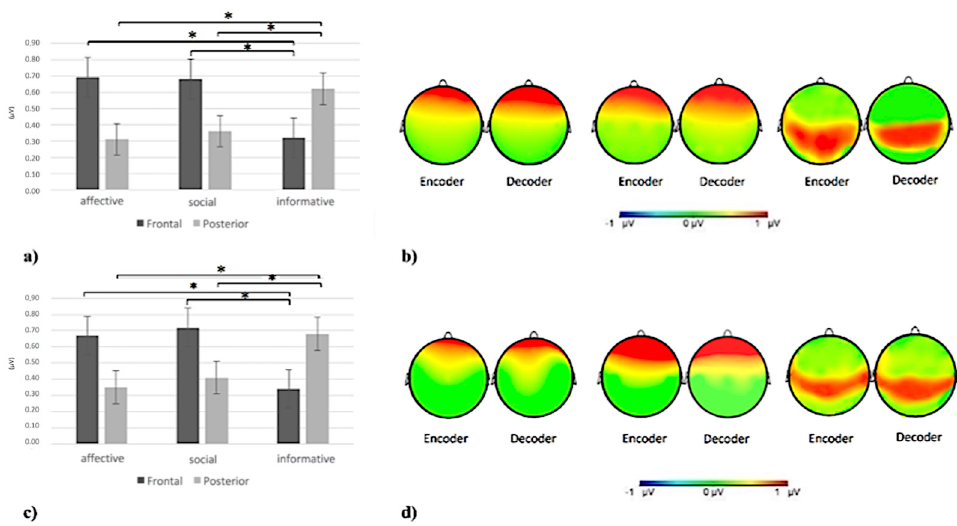
Figure 4. ( a ) Histogram of delta inter-brain connectivity for a ff ective, social, and informative gestures in the frontal and posterior (temporo-parietal) areas. The histogram shows an increase of delta inter-brain connectivity in the frontal area for a ff ective and social gestures and in the posterior (temporo-parietal) area for informative gestures. Bars represent ∓ 1SE. Stars mark statistically significant ( p < 0.05) pairwise comparisons. ( b ) Delta inter-brain connectivity representation, from left to right, for affective, social, and informative gestures in the encoder and decoder. The red area represents the increase of delta inter-brain connectivity. ( c ) Histogram of alpha inter-brain connectivity for affective, social, and informative gestures in the frontal and posterior (temporo-parietal) areas. The histogram shows an increase of alpha inter-brain connectivity in the frontal area for affective and social gestures and in